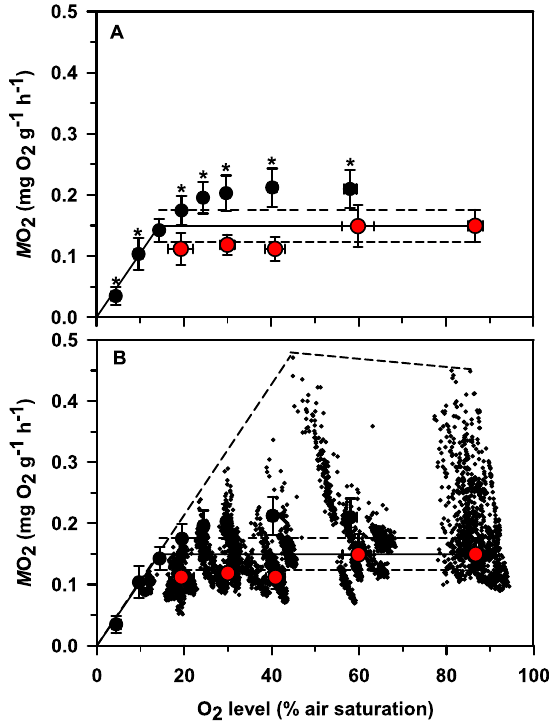
Figure 2. ( A ) The mass specific rate of oxygen consumption (  MO ) of A. frenatus subject to O 2 level changes (% 2 air saturation) in seawater as resolved by static intermittent flow respirometry. Data symbols are mean ± 95% CIs and are coloured in black to show the  MO response to an acute stepwise decline in O 2 (N = 12) and are 2 coloured in red to show SMR as a result of chronic O 2 exposures (N = 29; 6–8 fish per chronic O 2 treatment). The horizontal solid line shows an extrapolation of SMR from normoxic O 2 levels (including horizontal dashed lines showing 95% confidence limits). The S crit breaking point in SMR was calculated (see text for methodology) and found to occur at an O 2 level of 14.3% air saturation. An asterisk indicates a significant increase or decrease from the normoxic SMR control value (P < 0.05). ( B ) This plot contains the same data as in ( A ) above, but individual data from the chronic O 2 presentations are plotted to show the full range of measured  MO . Dashed 2 lines surround the upper limit of measured  MO 2